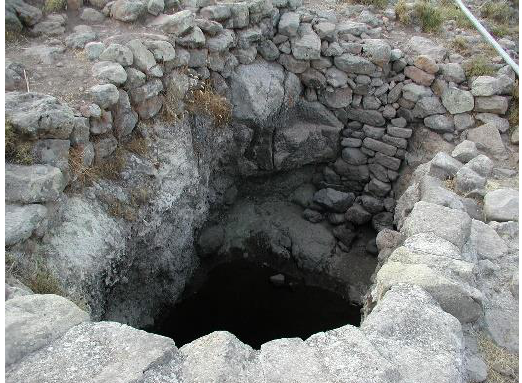
Figure 13. The cistern in the island of Aegina at Mpourdechtis area (photo: G. Antoniou). They are situated at a relatively high altitude and combine rainwater harvesting